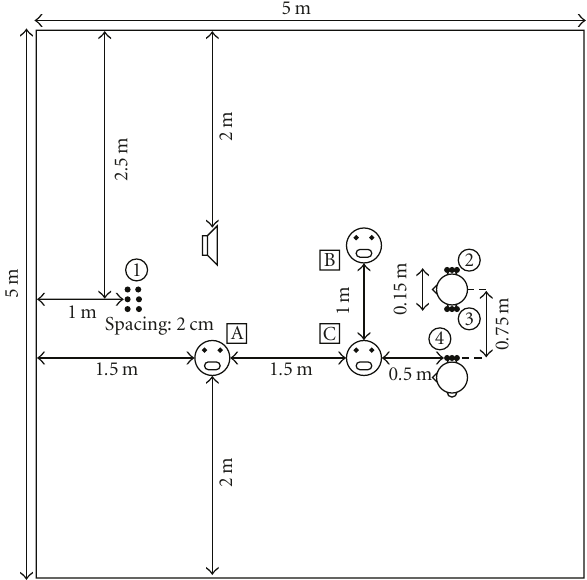
Figure 2: The acoustic scenario used in the simulations throughout this paper. Two persons with hearing aids are listening to speaker C. The other sources produce interference